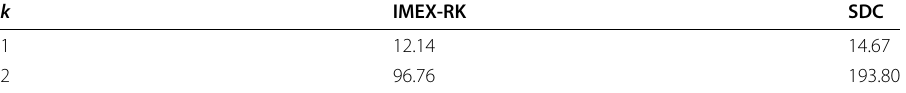
Table 3 Simulation CPU time(s) of IMEX-RK and SDC methods based on the uniform 64 × 64 mesh k IMEX-RK SDC 1 12.14 14.67 2 96.76